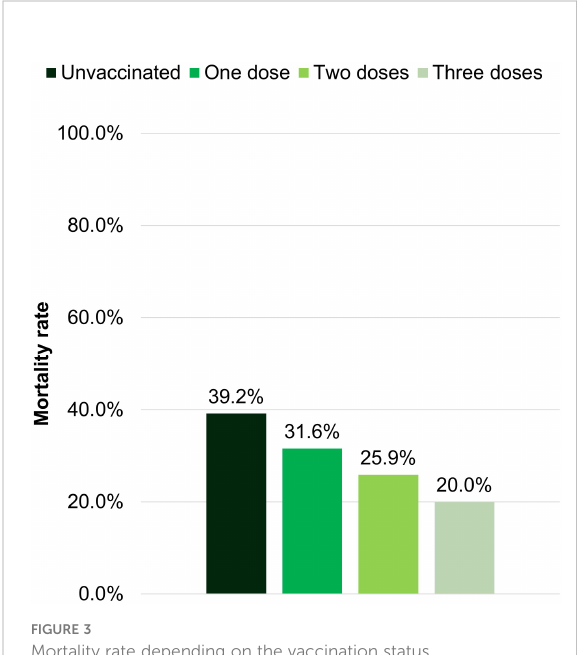
FIGURE 3 Mortality rate depending on the vaccination